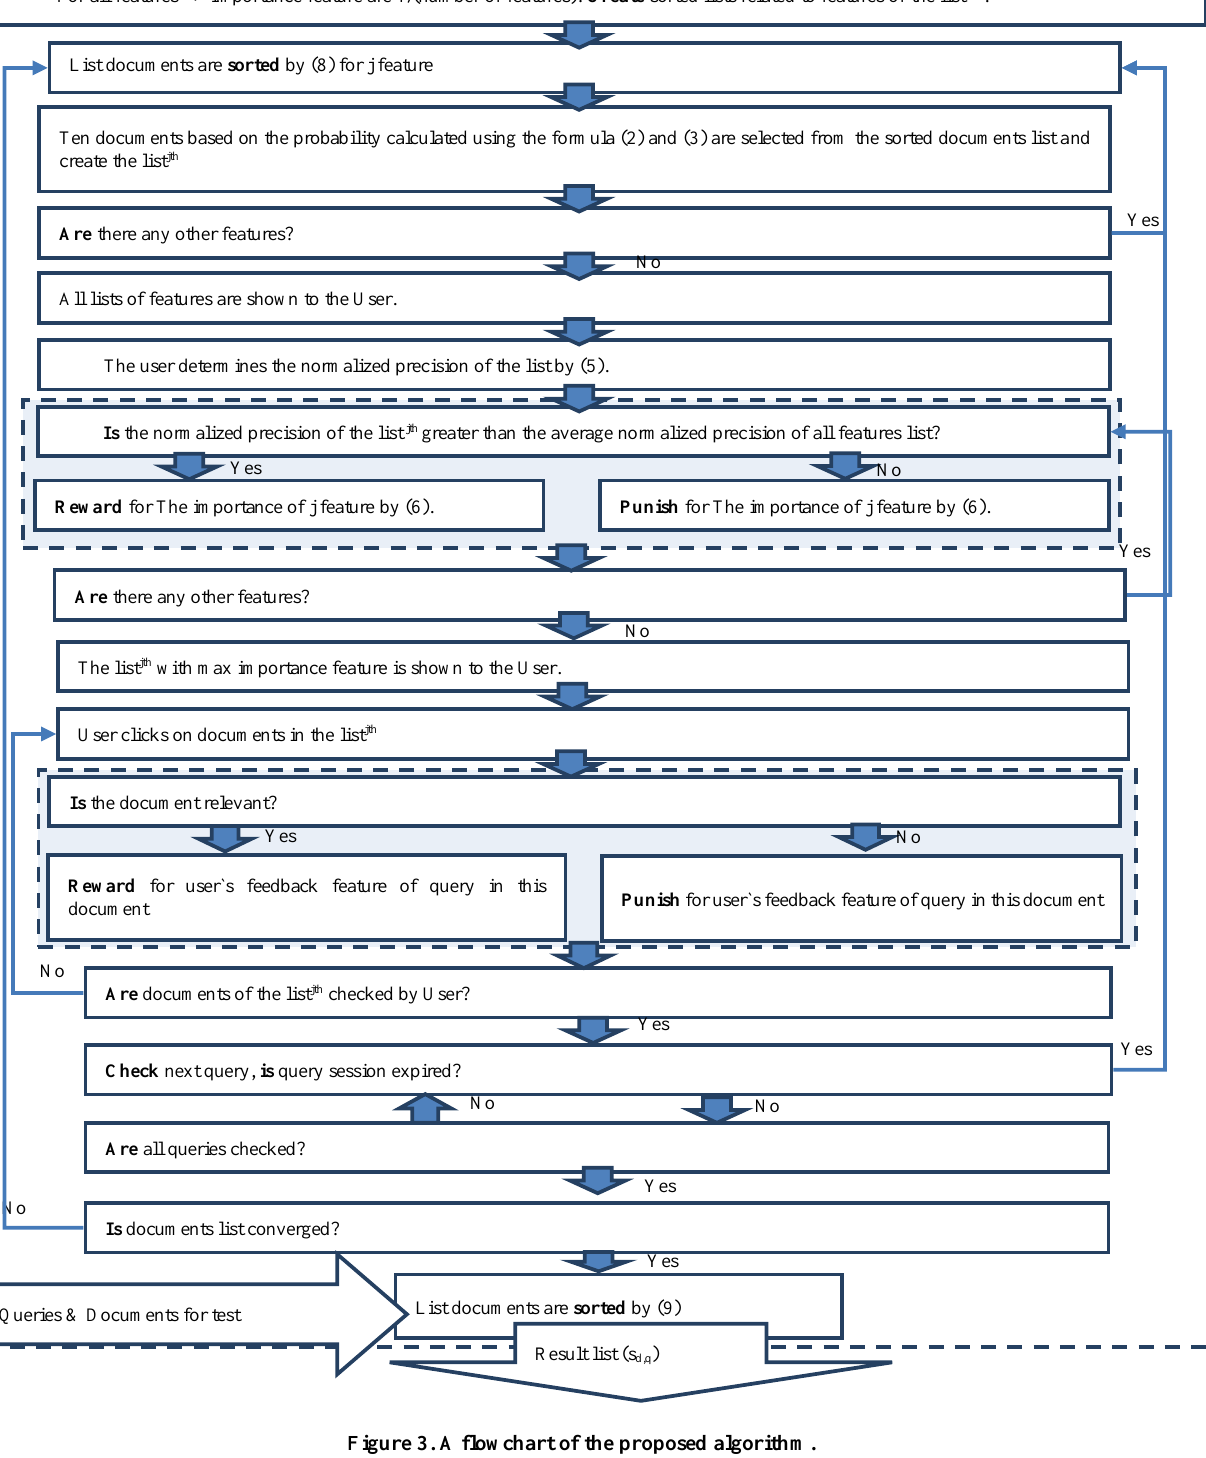
Figure 3. A flowchart of the proposed